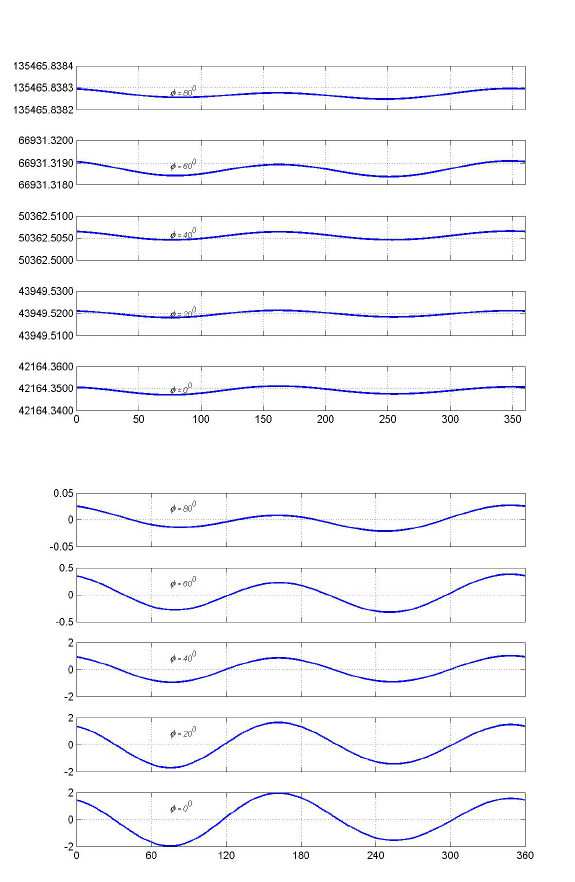
Figure 4: The vertical axes are (top) the radius of the zero gravity surface in km and (bottom) the change of the radius dr = r − ¯ r ( φ ) in m of the surface about its means ¯ r ( φ ) over parallels. The horizontal axis shows the longitude in